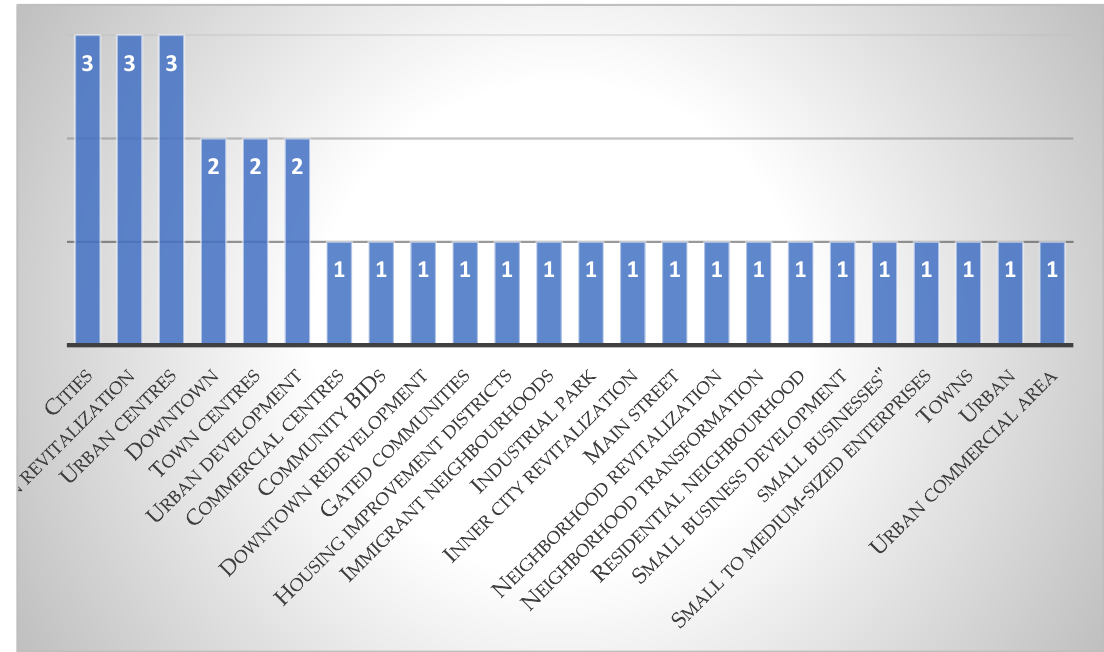
Figure 11. List of keywords from the research subject “BIDs: various types and places of intervention”. Source: author (2021), after initial screening and selection of publications.